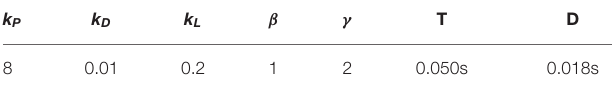
TABLE 1 | Parameters values of the PD-AILC torque